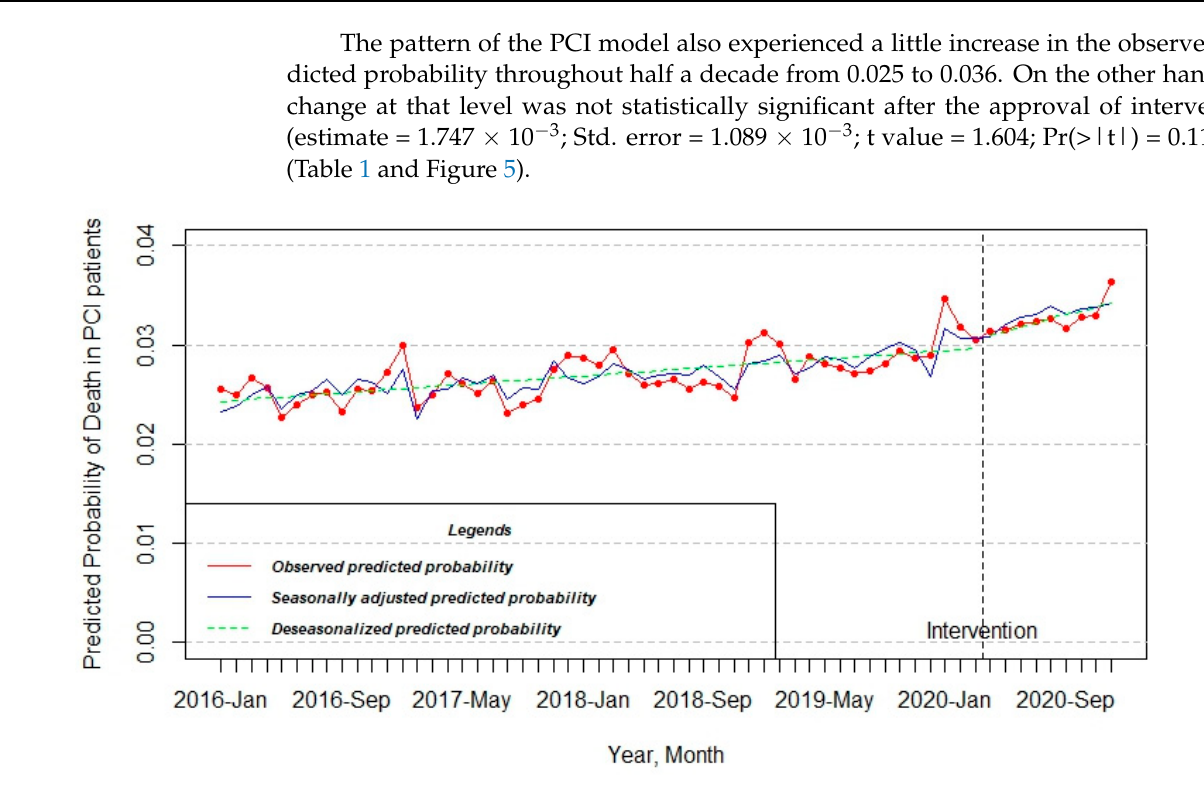
Figure 5. Interrupted time series model of the change of predicted probability of death in patients who underwent